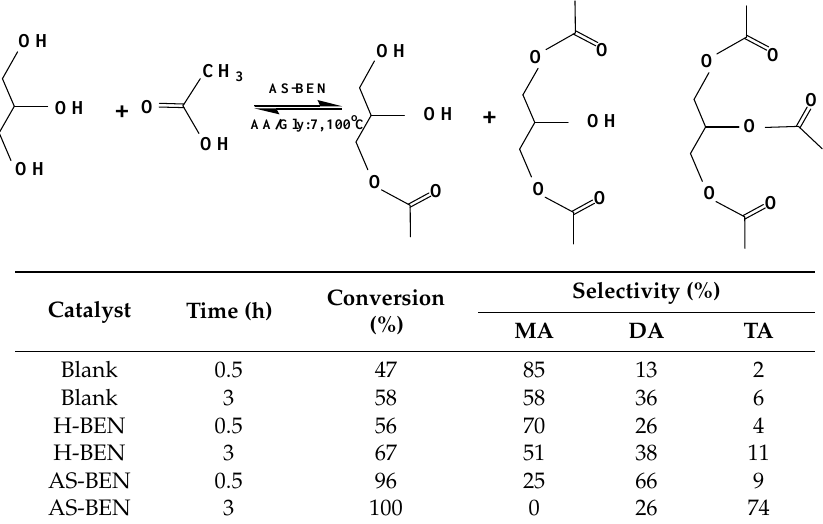
Table 2. Glycerol esterification reaction with acetic acid.